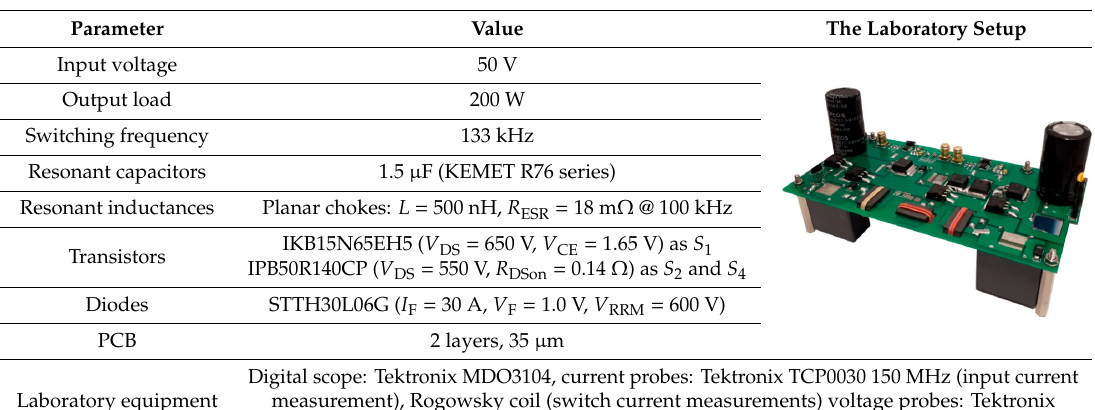
Table 5. The most important parameters of the laboratory converter.